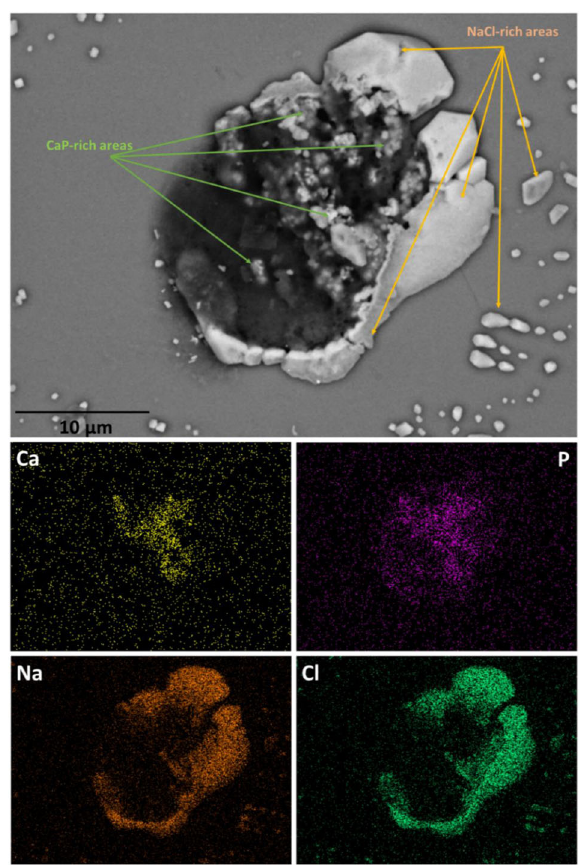
Fig. 8 a SEM image (main image) along with additional SEM-EDX information from quartz substrate for single U-2 OS cell derived from TI-HA-AD after 28 days in culture under standard conditions, b zoomed- in SEM image from ( a ) and ( c ) point spectra corresponding to red dot within ( b ). Scale bar represents 10 µm distance within main